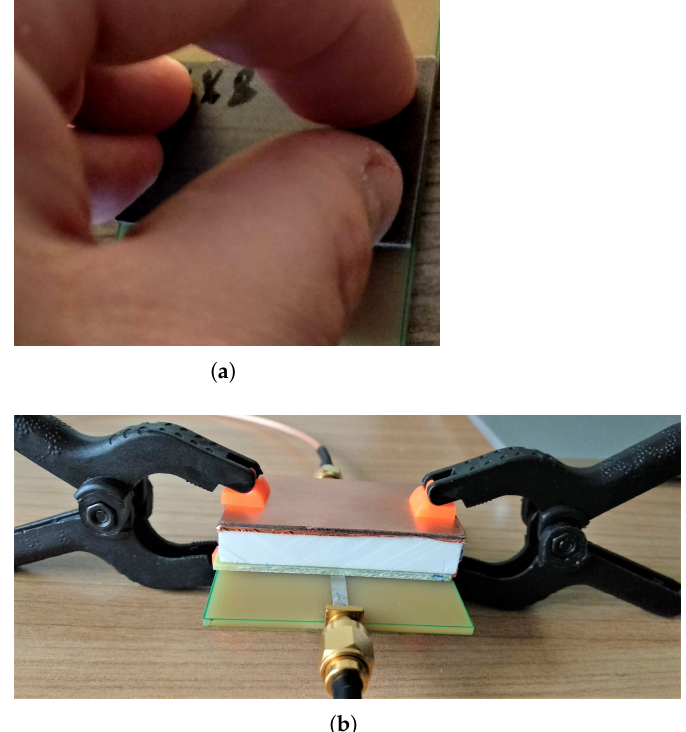
Figure 10. Comparative measurements of SUTs by “simplified” MRR configuration vs. the “original” MRR configuration with a PTFE cover layer and a ground plane on top. ( a ) “4-finger” simplified configuration. ( b ) original